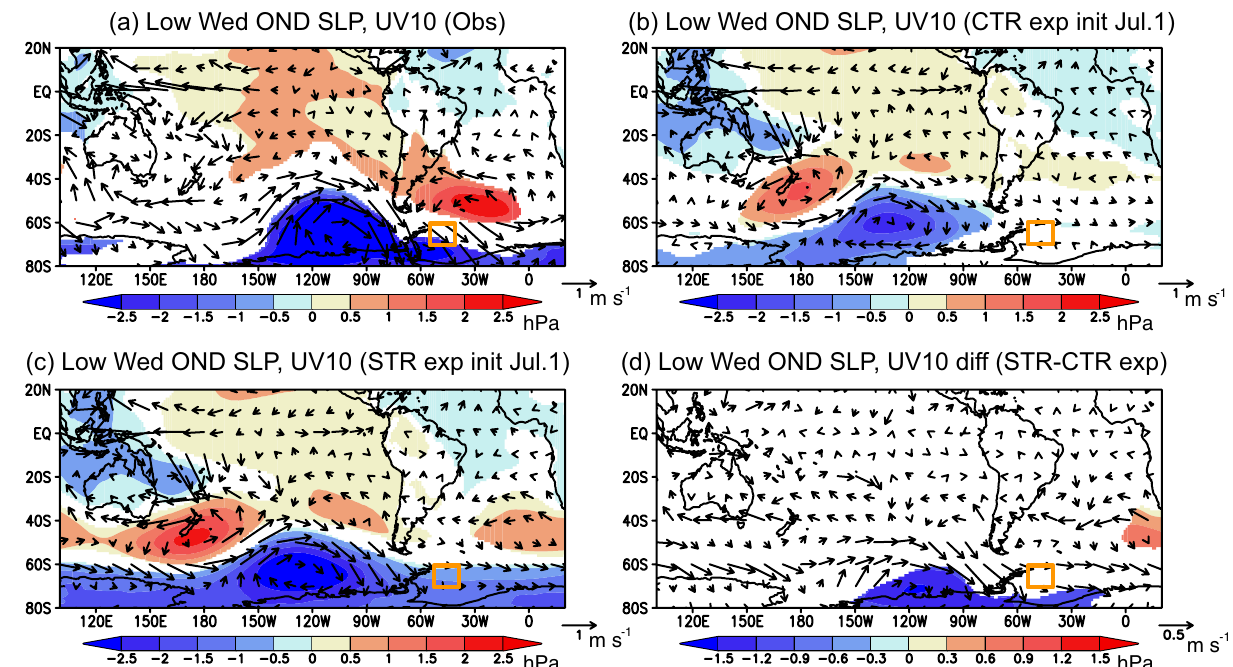
Figure 8. ( a ) Composite anomalies of sea-level pressure (SLP in hPa) and horizontal winds at 10 m from the surface (UV10 in m s −1 ) during October-December of low sea-ice years in the Weddell Sea. Atmospheric reanalysis is shown here. Colors indicate anomalies that are statistically significant at 98% confidence level using the two-tailed Student’s t -test. An orange box corresponds to the Weddell Sea region of interest. ( b ) Same as in ( a ), but for the anomalies predicted from July 1st in the CTR experiment. ( c ) Same as in ( b ), but for the anomalies predicted from July 1st in the STR experiment. ( d ) Differences in the composite anomalies between the STR and CTR experiments, i.e., ( c )–( b